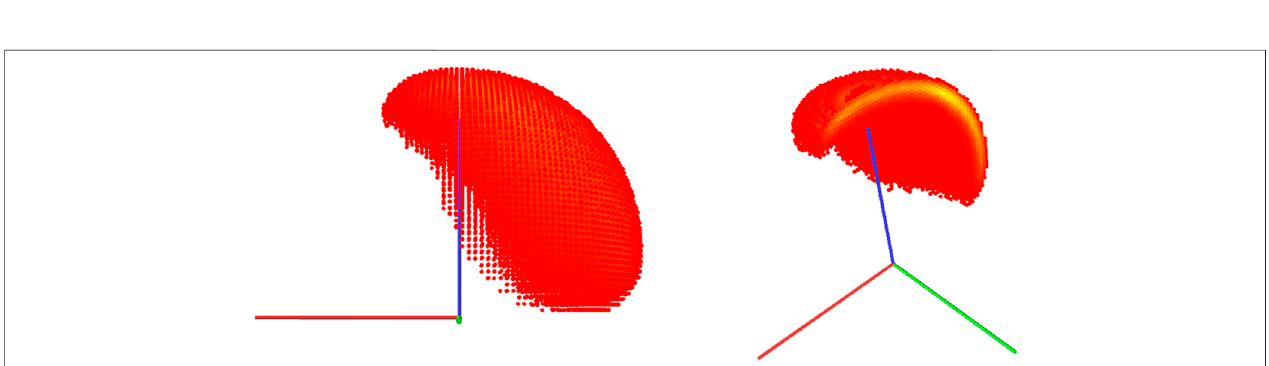
FIGURE12| Capability map spannedfrom thefailure diagram in Figure10bottom ,and cross-sectionofthesame map. Itcorresponds tothepost-failurereturn- safe workspace only for the relevant self-motion manifold.